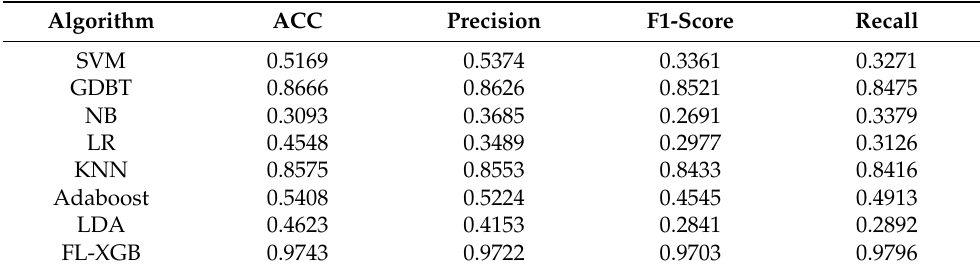
Table 8. Identification results of different algorithms.